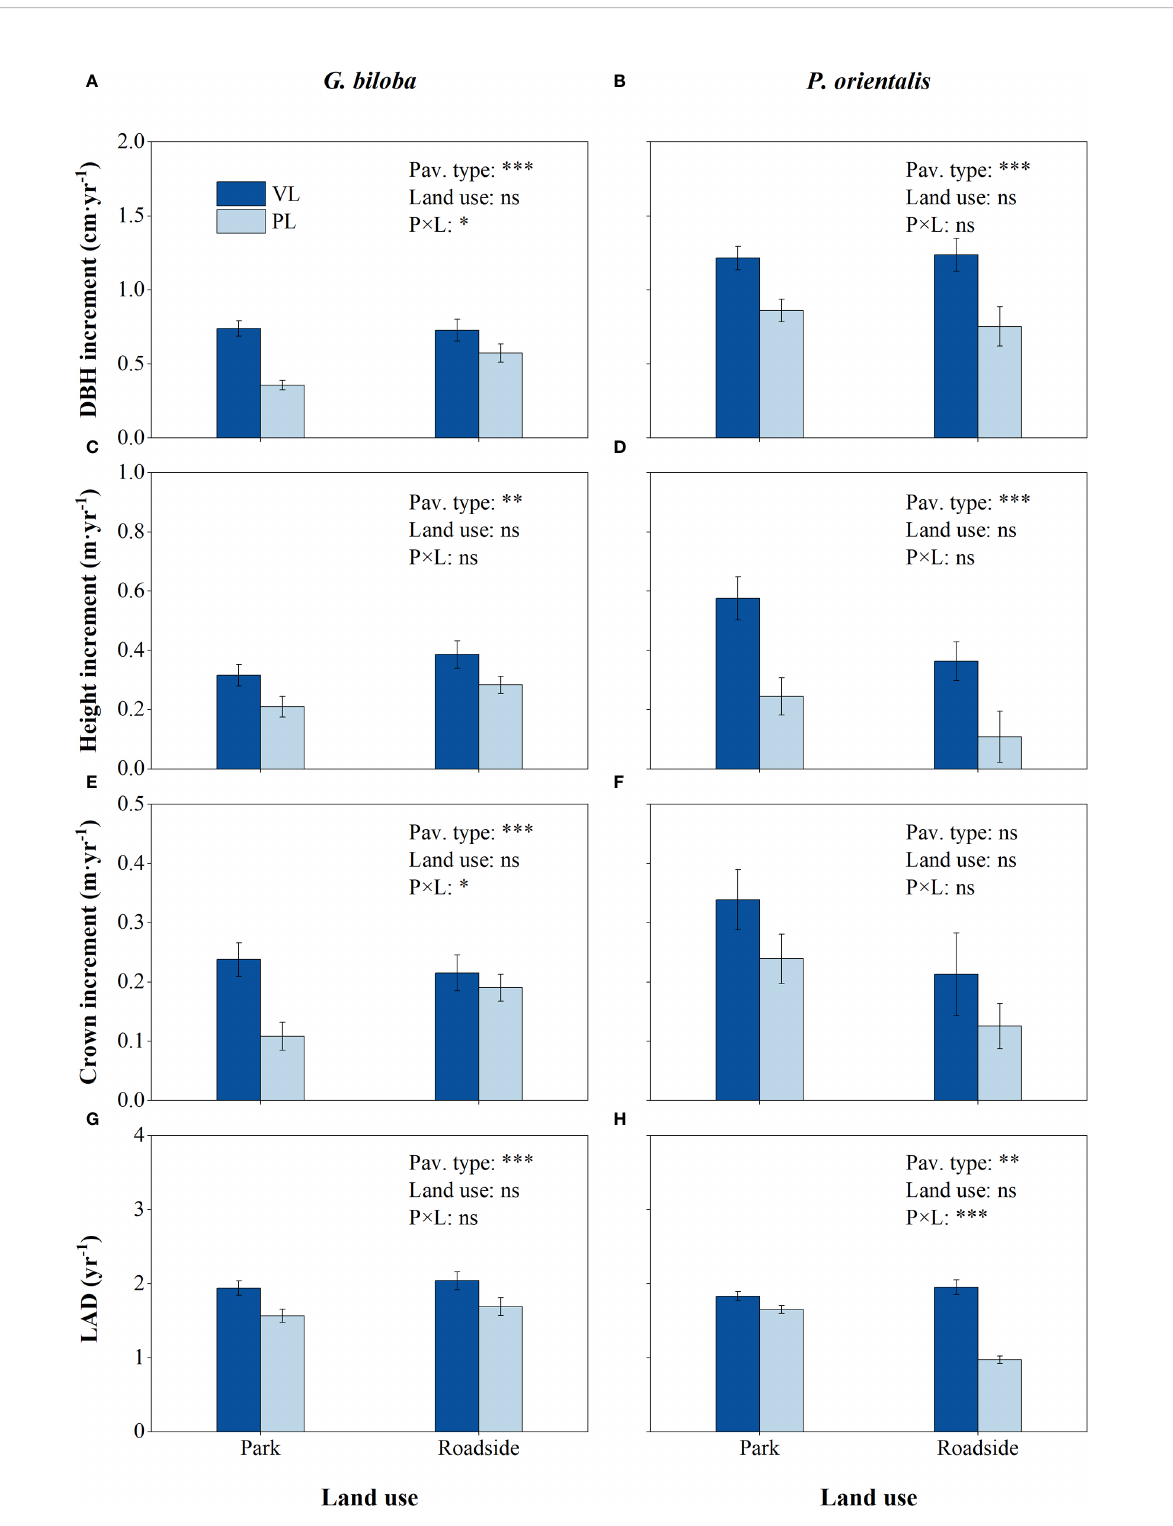
FIGURE 2 Results from the linear mixed-effects model (LMM) testing for the differences in the DBH increment (A, B) , height increment (C, D) , crown increment (E, F) , and leaf area density (LAD) (G, H) vs. the pavement type (VL, vegetated land; PL, paved land), land use (park and roadside), and their interactions. *, P < 0.05; **, P < 0.01; ***, P < 0.001; ns, not signi fi cant. Data represent mean ±